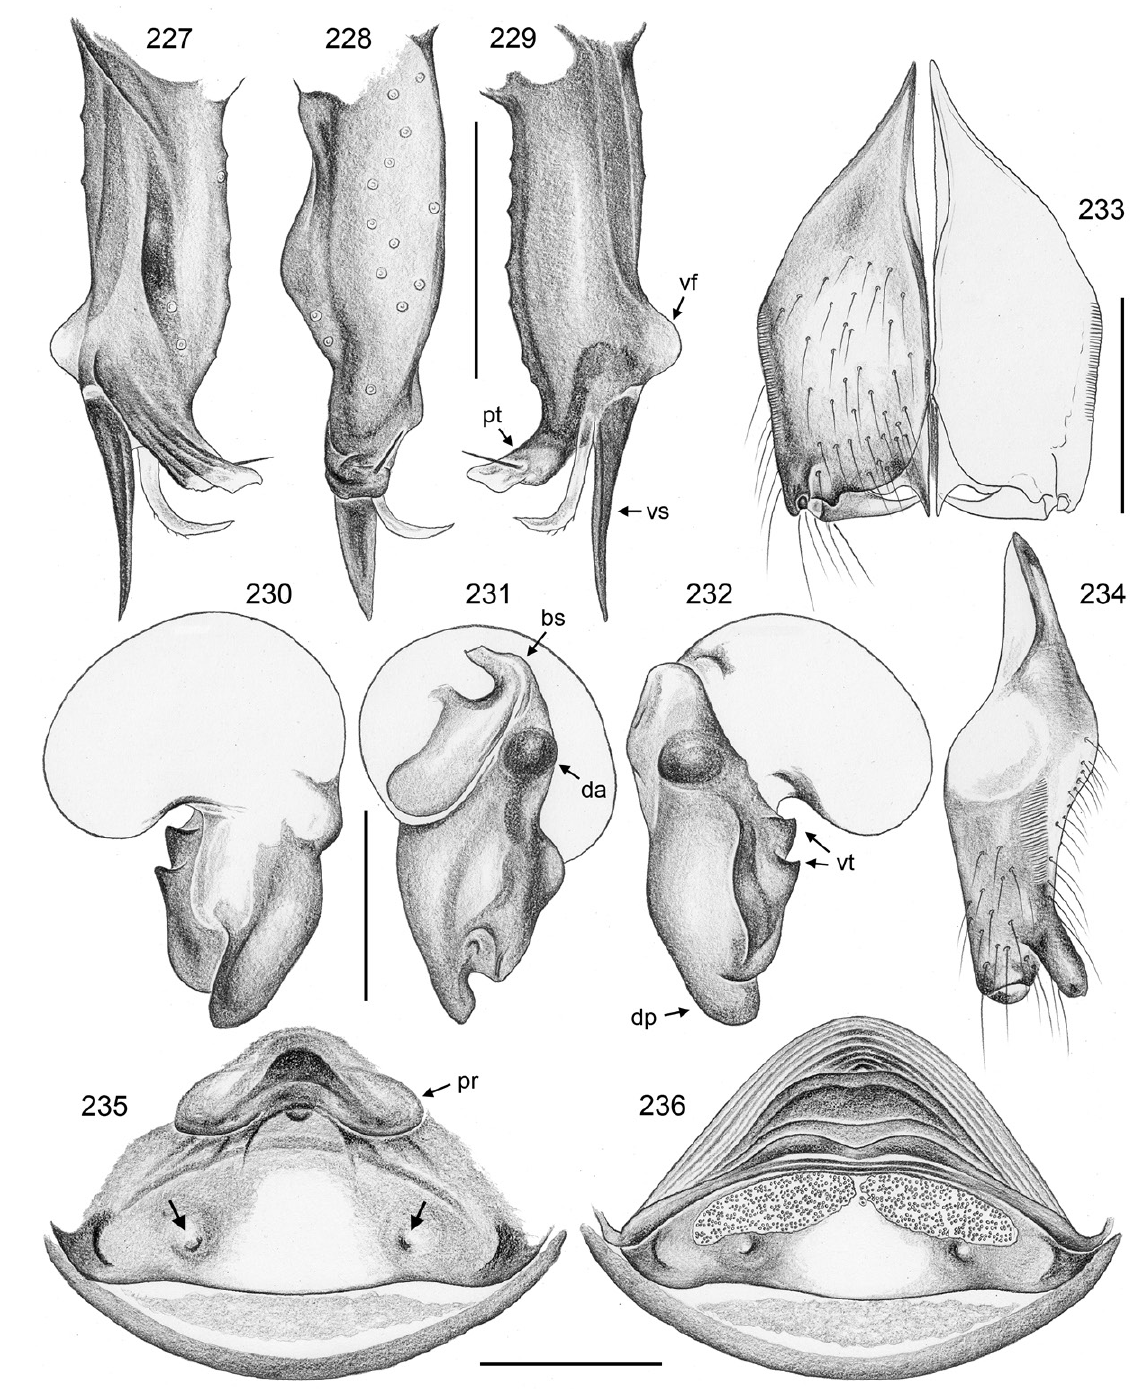
Figs 227–236. Maghreba stifadma gen. et sp. nov.; male and female from Morocco, Setti-Fatma (ZFMK Ar 22368, Ar 22369). 227–229 . Left procursus, prolateral, dorsal, and retrolateral views. 230–232 . Left genital bulb, prolateral, dorsal, and retrolateral views. 233–234 . Male chelicerae, frontal and lateral views. 235–236 . Cleared female genitalia, ventral and dorsal views; arrows: pockets (pits). Abbreviations: bs = basal sclerite; da = dorsal apophysis; dp = dorsal process; pr = epigynal process; pt = procursus tip; vf = ventral flap; vs = ventral sclerite; vt = ventral teeth. Scale bars = 0.3